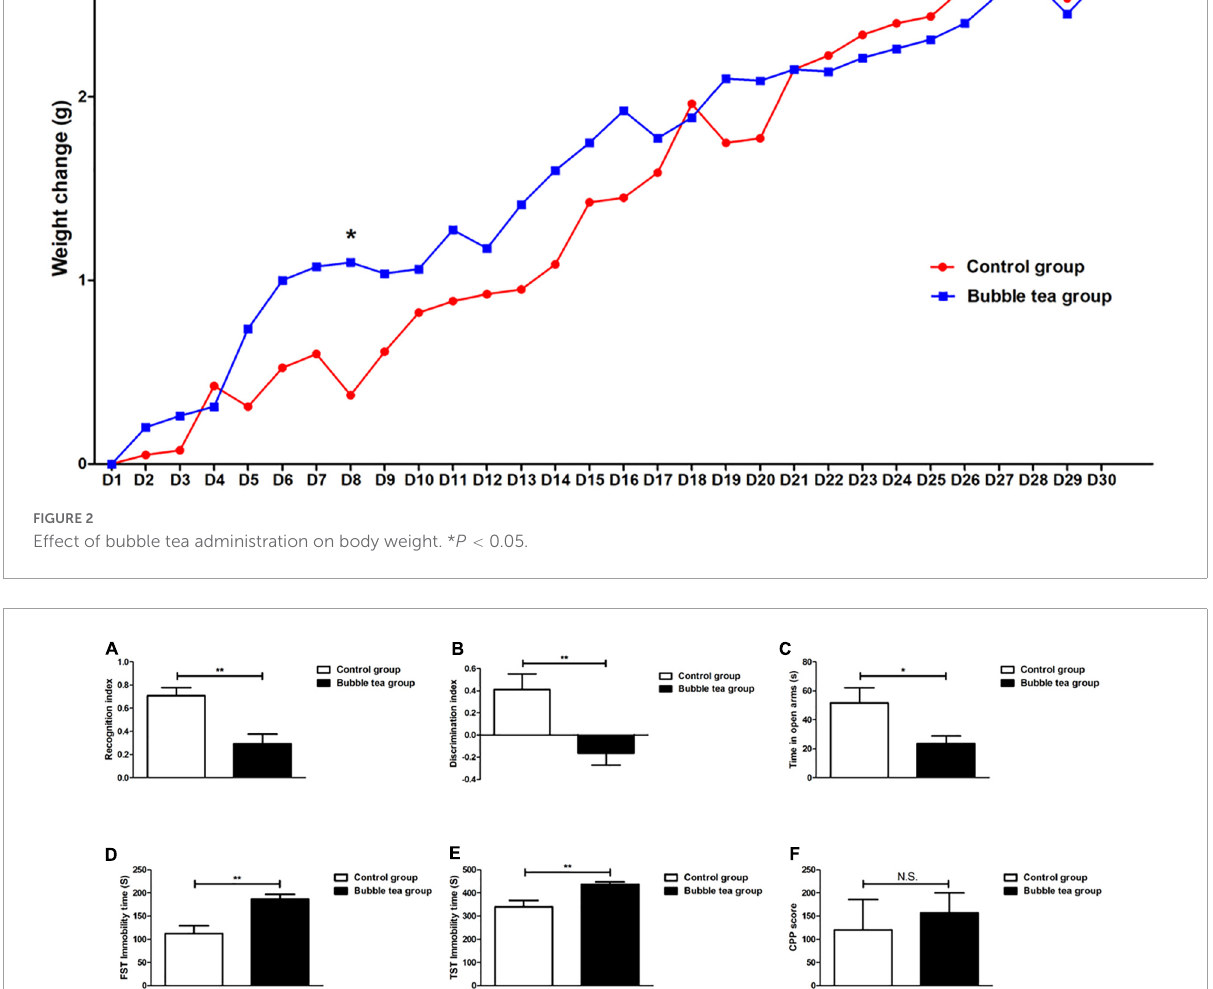
FIGURE3 Effect of bubble tea administration on cognition function, anxiety and depressive, and addiction behavior. (A) Columns represent the recognition index in NORT. Independent-samples t-test, two tailed. (B) Columns represent the discrimination index in NORT. Independent-samples t-test, two tailed. (C) Columns represent the time that mice were in the open arm of the EPMT. Independent-samples t -test, two tailed. (D) Columns represent the immobility time of mice in the FST. Independent-samples t -test, two tailed. (E) Columns represent the immobility time of mice in the TST. Independent-samples t -test, two tailed. (F) Columns represent the CPP scores of mice. Independent-samples t -test, two tailed. * P < 0.05 and ** P <